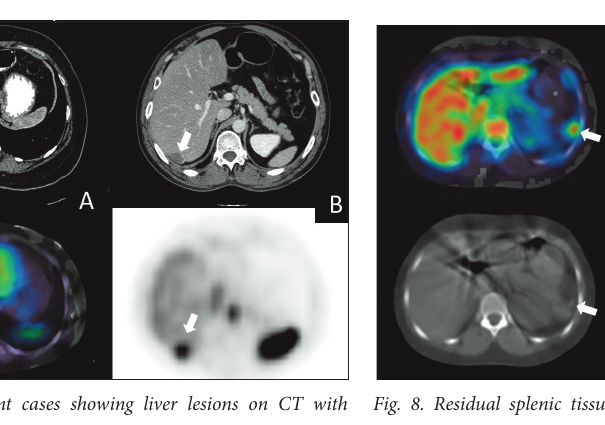
SPECT/CT.Fig. 6. Different cases showing pulmonary emboli as (A) a perfusion-ventilation mismatch using VQS, and (B) as an arterial filling defect on CTPA.